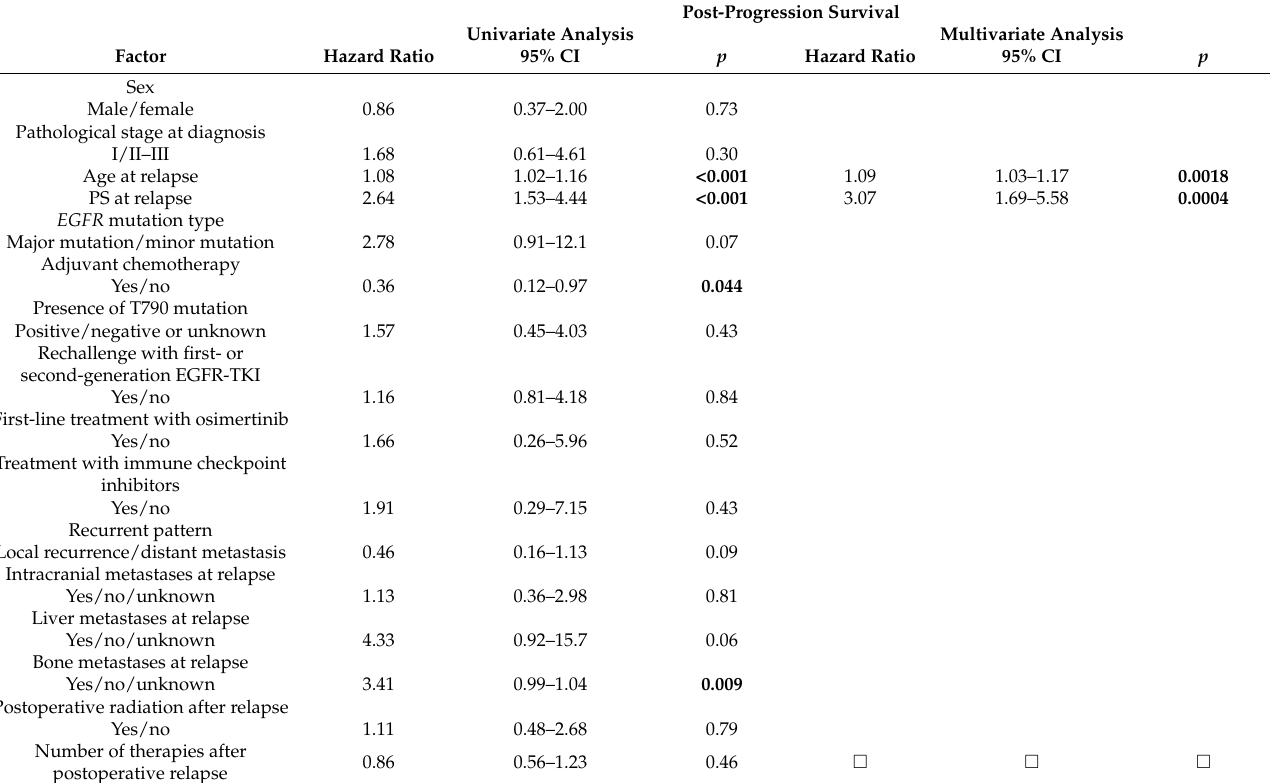
Table 3. Univariate and multivariate analyses of patient backgrounds for post-progression survival.